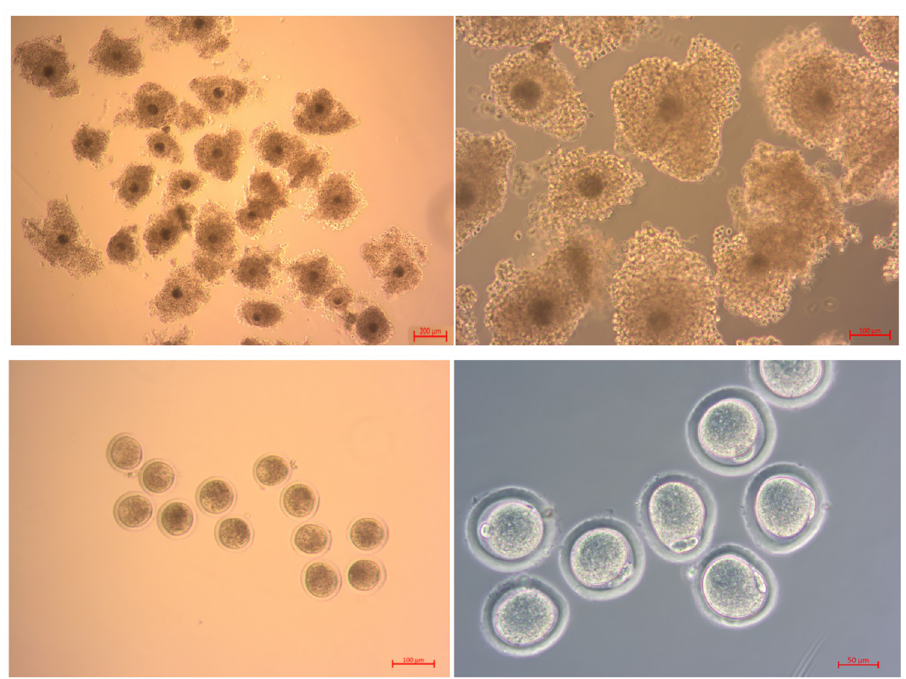
Fig 1. Types of guinea pig oocytes and their meiotic progression during IVM. (A,B,C) Compact COCs collected from the ovaries of guinea pigs. Type A oocytes have three or more layers of cumulus cells (A). Type B oocytes have 1–3 layers of cumulus cells (B). Type C oocytes have few or no cumulus cells (i.e., naked oocytes) (C). (D) Oocytes at the MII stage (matured oocytes) induced from Type A oocytes showing the first polar body (arrow). Scale bar = 200 μ m in (A); 100 μ m in (B, C); 50 μ m in (D).